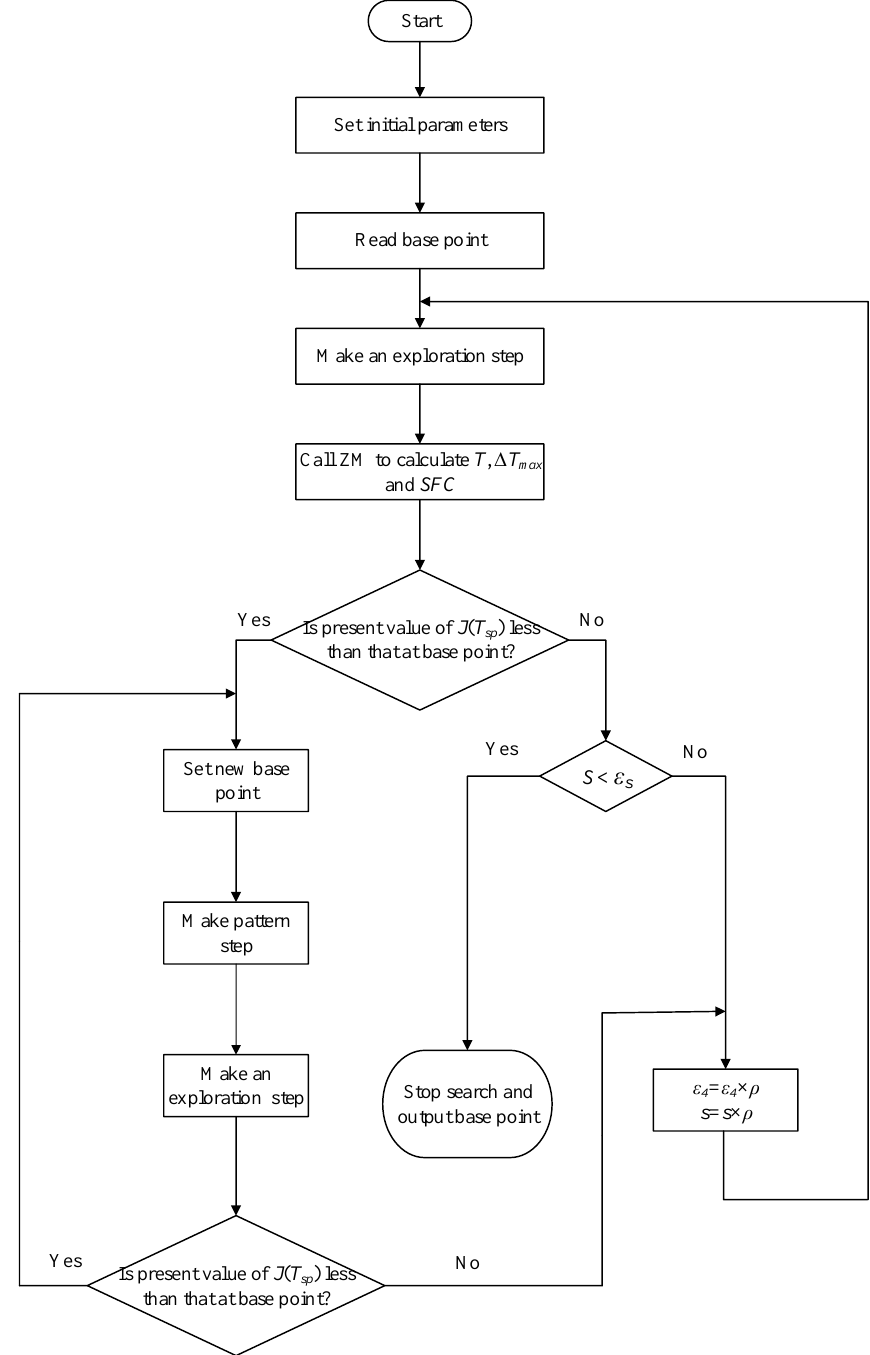
Figure 4 . Flow chart of Hooke-Jeeves direct search algorithm ( HJDSA) for seeking desired set-point